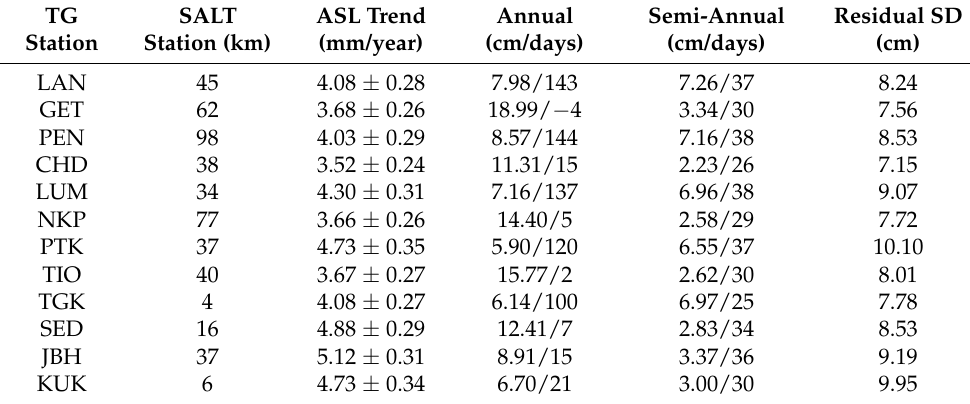
Table 5. ASL trend results (1992–2020) from SALT for the TG locations in East Malaysia (Sarawak and Sabah). The average distance of the altimeter along-track data to the TG station location is given in the 2nd column. For the periodic cycles (annual and semi-annual), the amplitude and phase are given where the latter is transformed to days after 1 January. The residual sigma is the SD of the difference between data and model fit. The ASL trend estimates are given at a 95% (1.96 sigma) confidence level. TG SALT Station Station (km)